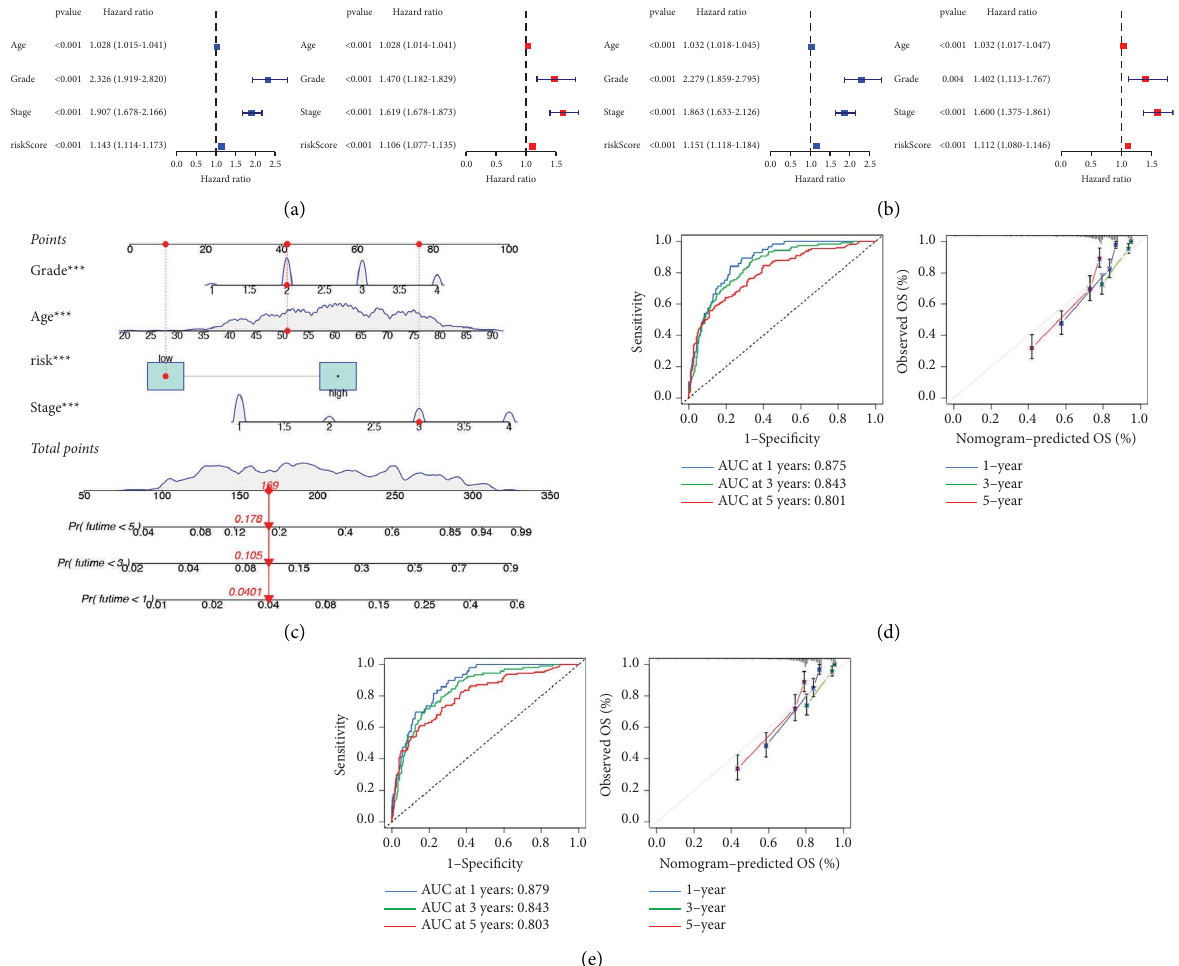
Figure 8: Development and validation of prognostic nomogram: (a–b) forest plots of the univariate and multivariate cox regression in training and validation cohorts, (b) nomogram composed of age, grade, stage, and risk score with the prediction of overall survival rate, (d–e) ROC and calibration curves of nomogram for the prediction of overall survival rate in training and validation